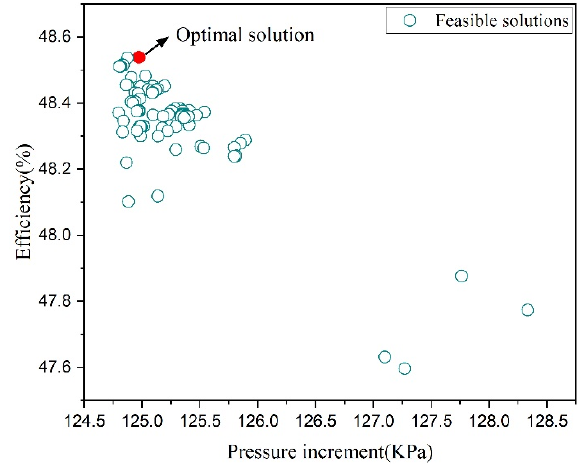
Figure 8. Goodness of fit curve for the Sparse Grid method.